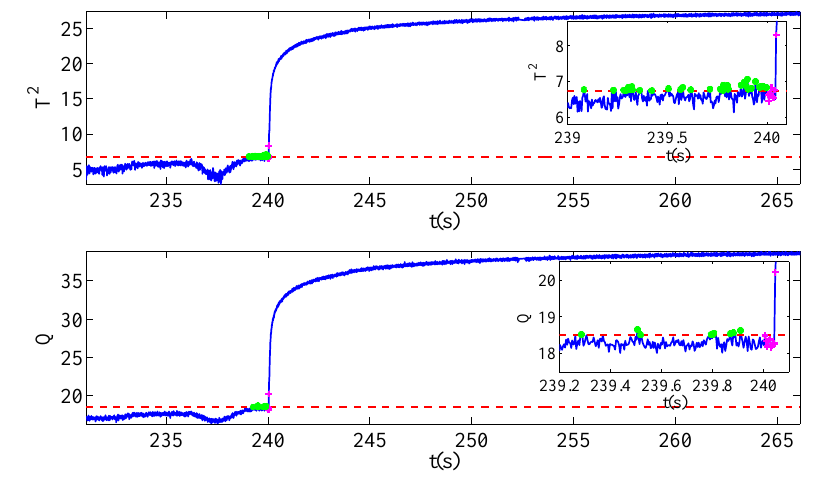
Figure 5. Fault detection results for f 2 .